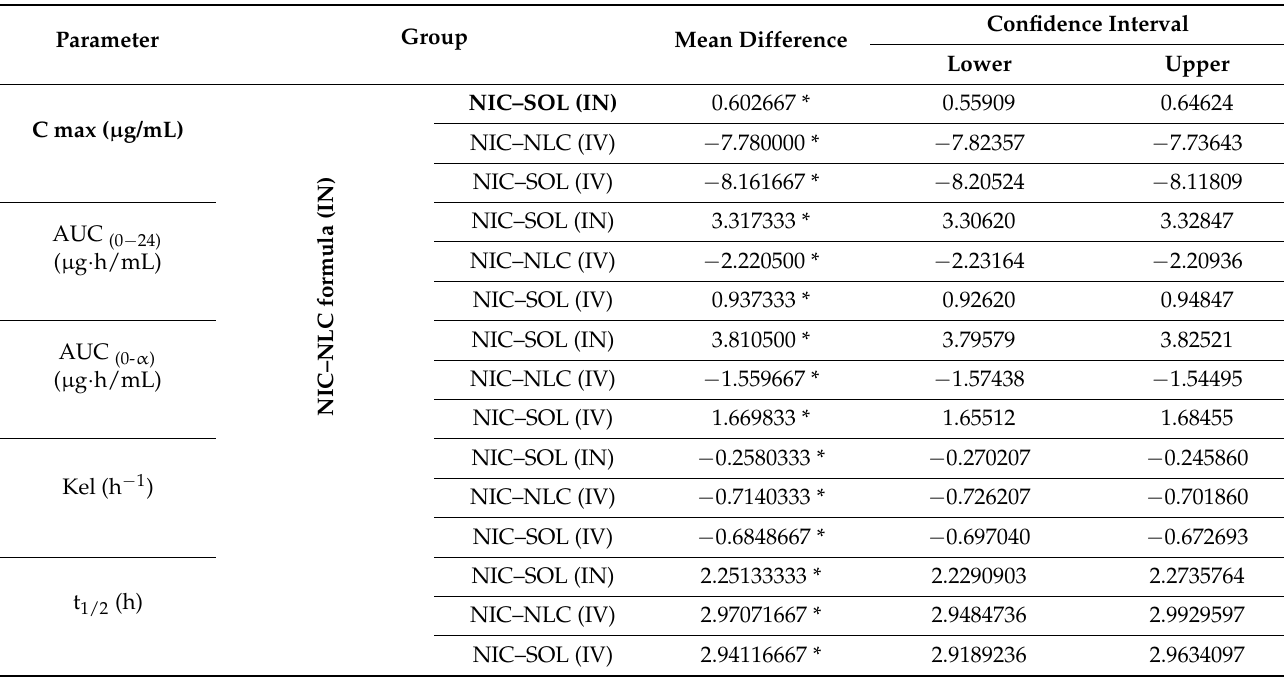
Table 8. Post hoc statistical analysis of the calculated mean differences of different pharmacokinetic parameters in plasma.